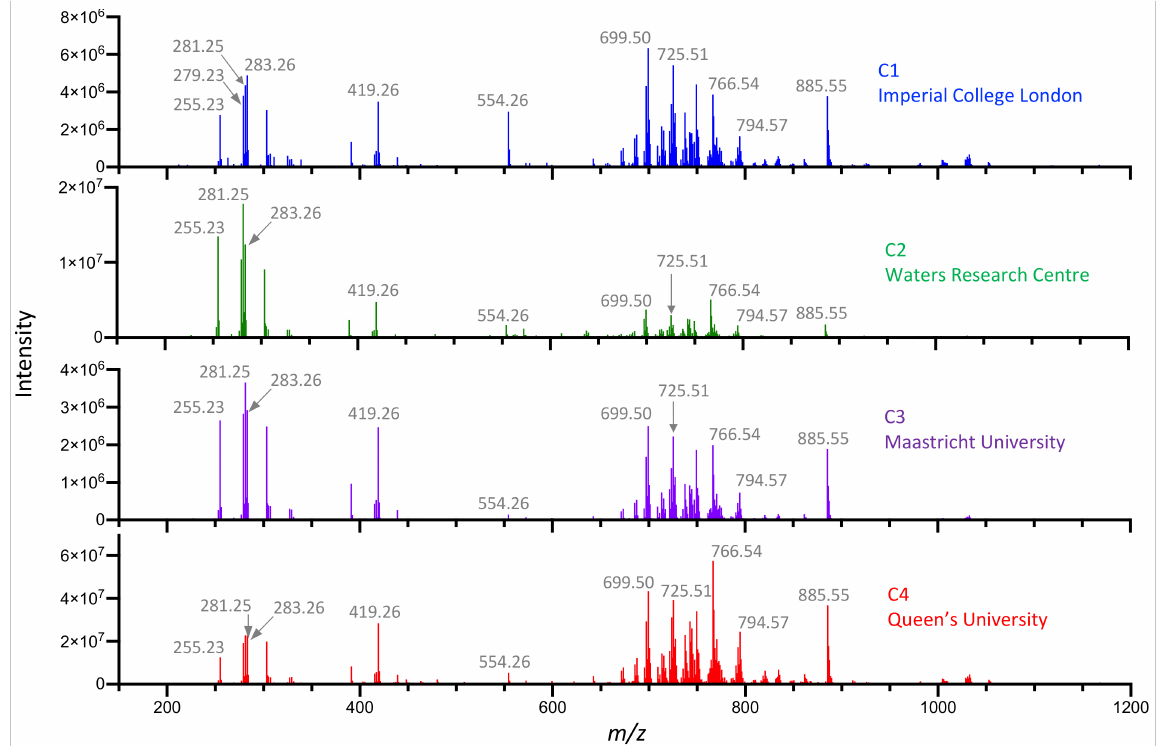
Figure 2. REIMS spectra of single-source pork liver acquired at each center. A single source of pork liver (Batch 1) was distributed by C1 to all other centers. REIMS spectra comparison of pork liver from each center in the m/z range of 100–1200. Each representative spectrum shown is the average of 6–7 individual